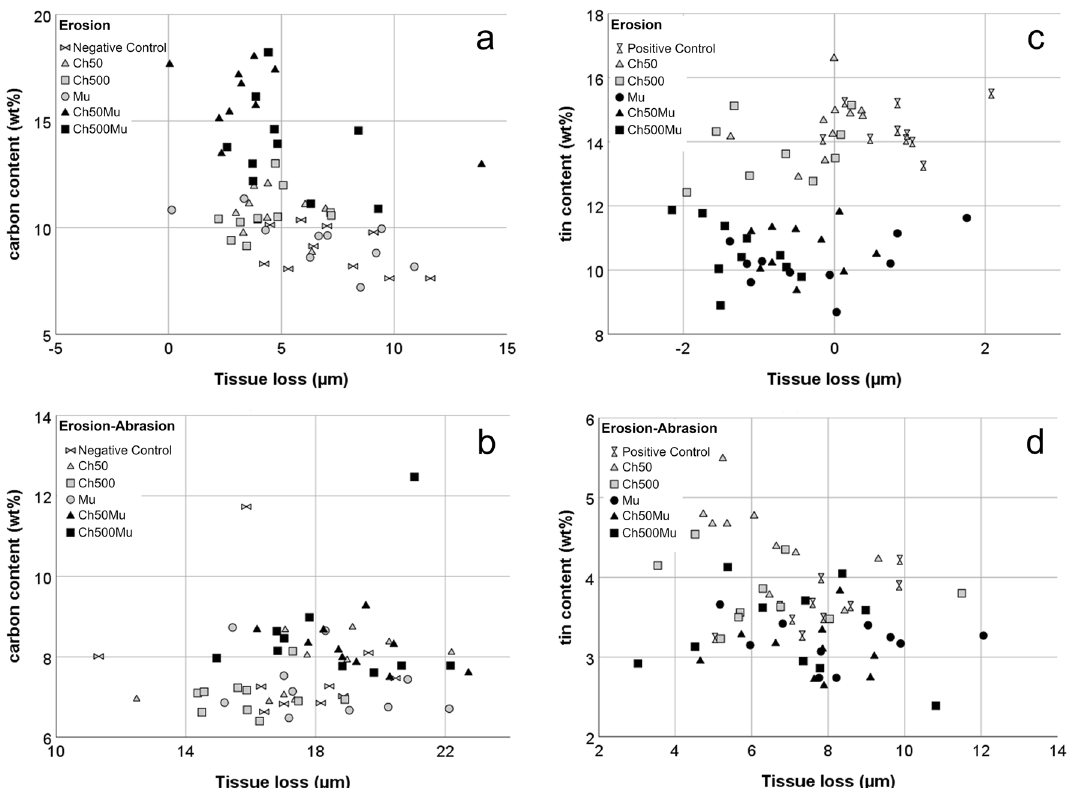
Figure 2. Scatterplot of results of tissue loss in relation to carbon content (left column ( a / b ), groups of experiment 1 only; no stannous ions) and to tin content (right column ( c / d ), groups of experiment 2; treated with F/Sn) under erosive (upper row; a / c ) and erosive-abrasive conditions (lower row; b / d ). For carbon content no positive control (F/Sn only) is displayed; for tin content no negative control (without active agents) is displayed. The dots are marked according to group assignment. Negative Control = without active agents; Positive Control = F/Sn only; Ch50/Ch500 = chitosan with viscosities of 50 mPas/500 mPas; Mu = porcine gastric mucin; Ch50Mu/Ch500Mu = combination of chitosan and mucin in separate solutions (application order chitosan first, mucin second). For the carbon content the results are split into one polymer (grey) and two polymers (black). For tin content the results are marked according to the charge of the last applied agent (grey: positively charged; black: negatively charged). After application of two polymers the amount of carbon increased; the retained amount of tin decreased in case of negative charge of the last applied